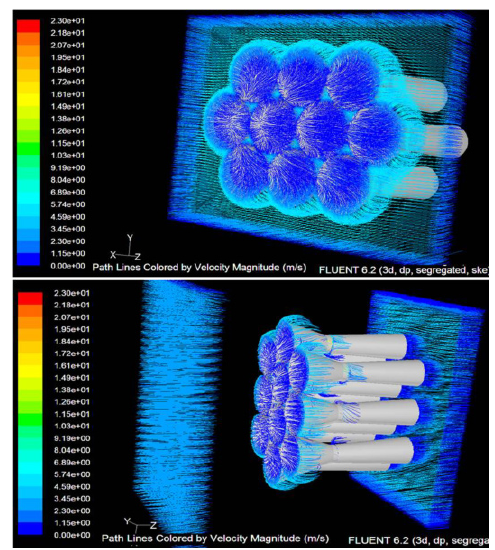
Figure 10. Path line diagram for CMMCT array pladed in free flow of 2.5 m/s undisturbed flow